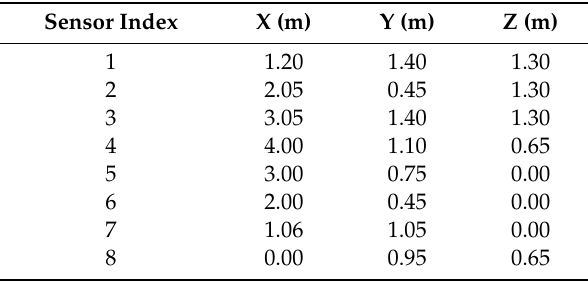
Table 5. Coordinates of AE sensors.